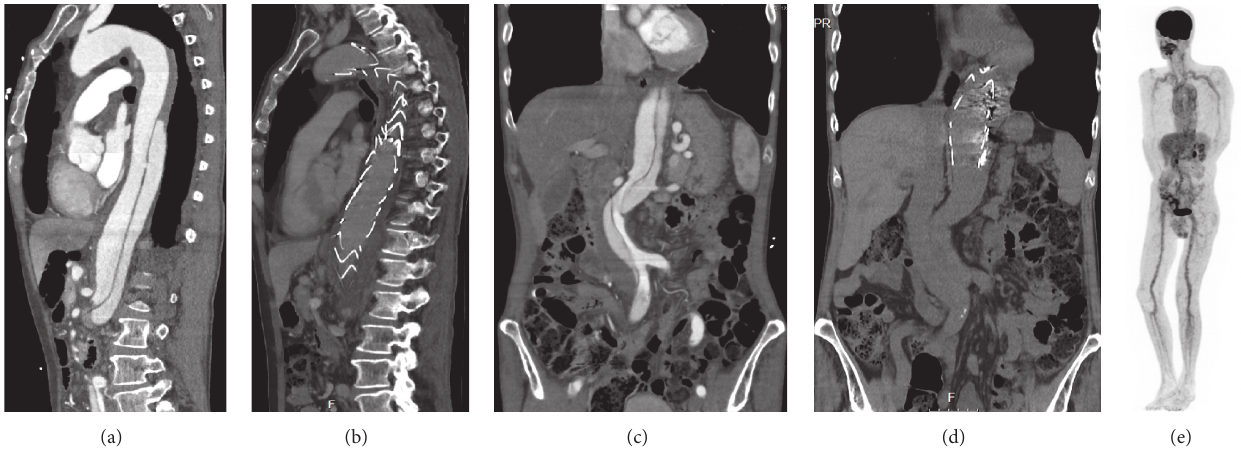
Figure 1: Radiological investigations. Sagittal ((a) and (b)) and coronal ((c) and (d)) reconstructions of CT scans, demonstrating type B aortic dissection and elongated aorta before and after TEVAR. The entry tear is demonstrated at the level of thoracic 10. 18-Fludeoxyglucose PET scan (e), demonstrating large vessel vasculitis.